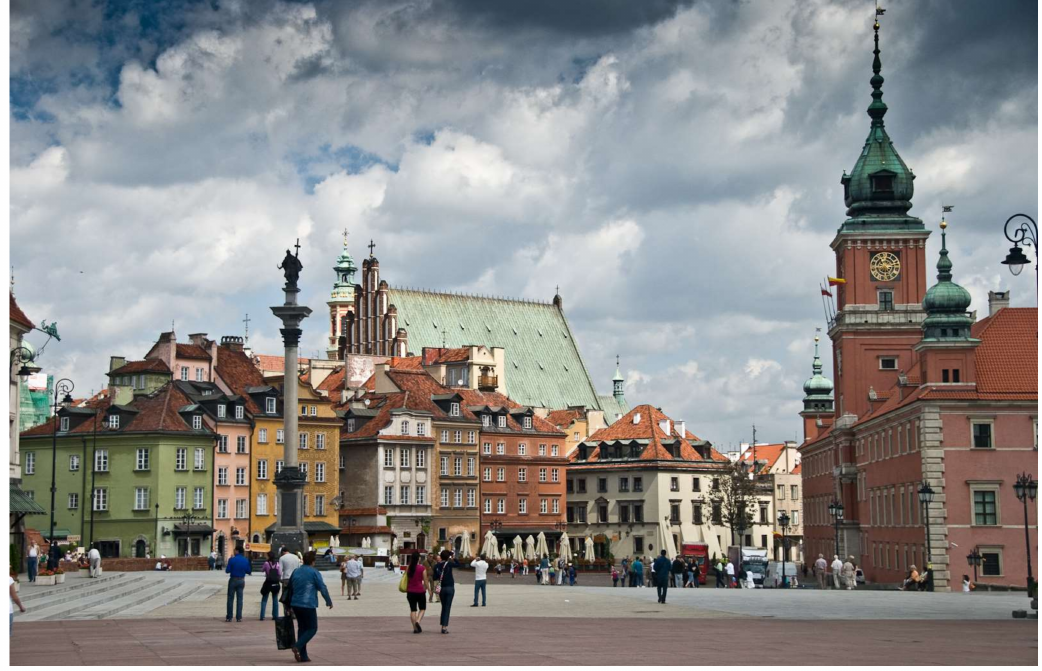
Figure 7. Royal Castle Square, Warsaw 2009. Photo: Paweł Kowalow (CC BY-SA 2.5), available online: http://warszawa.wikia.com/wiki/Plik:Plac_zamkowy_zamek_krolewski.jpg (accessed on 1 March